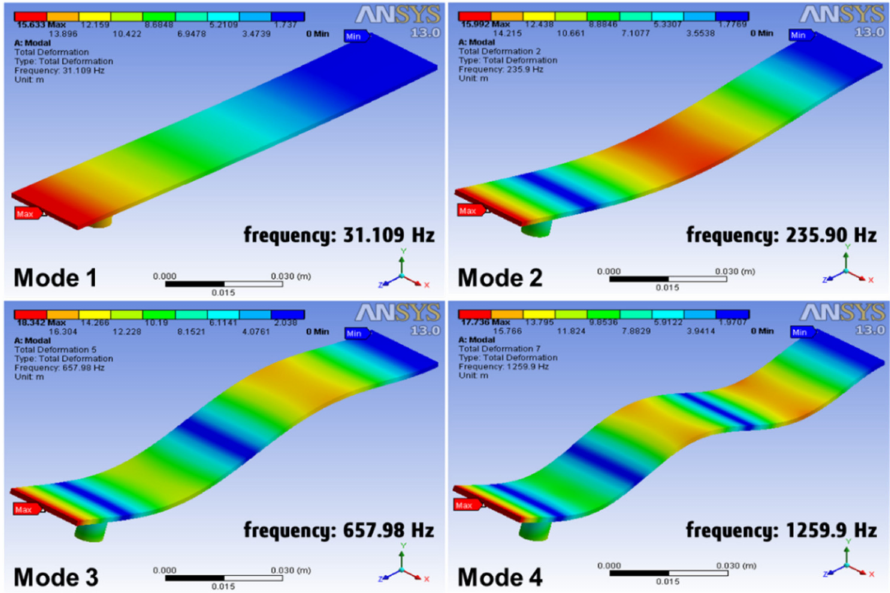
Figure 7. Mode shapes for a single specimen (W = 24 mm) in Group